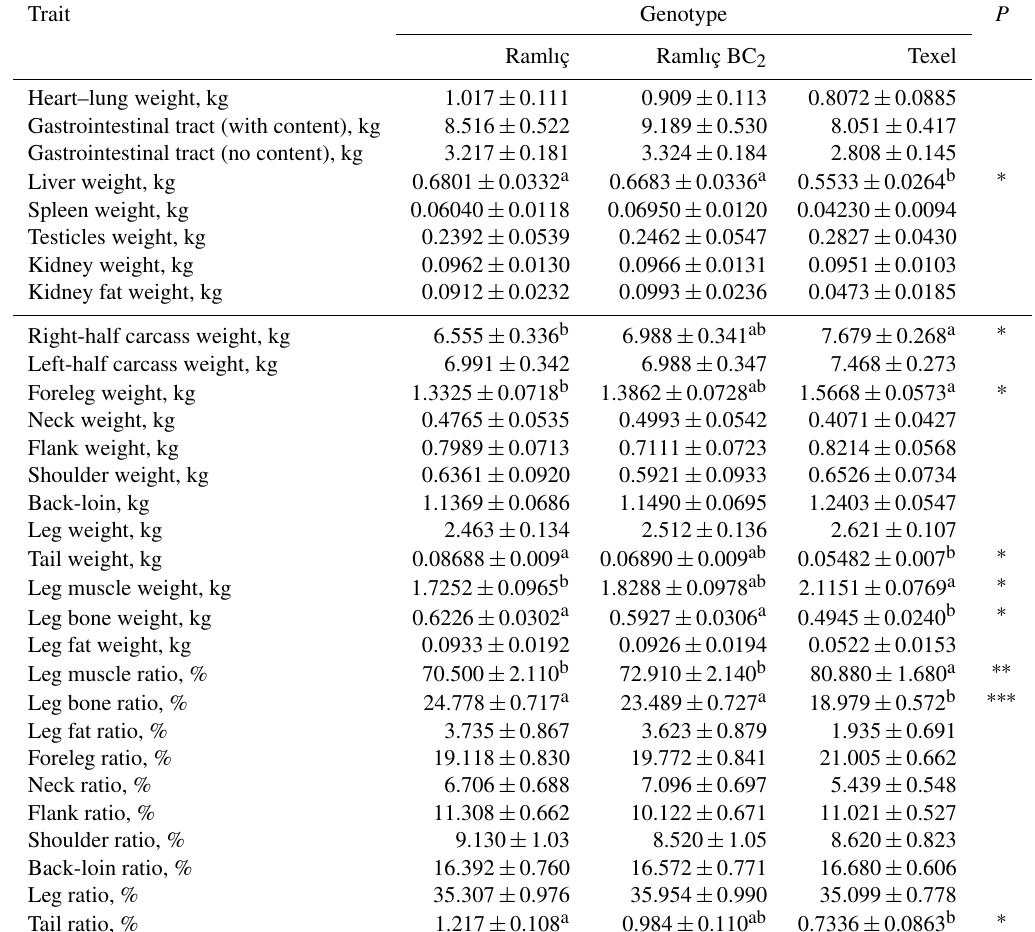
Table 3. Least-squares means for organ weights and carcass joints (weight and ratio) of Ramlıç, BC 2 ( + / − ) and Texel lambs.